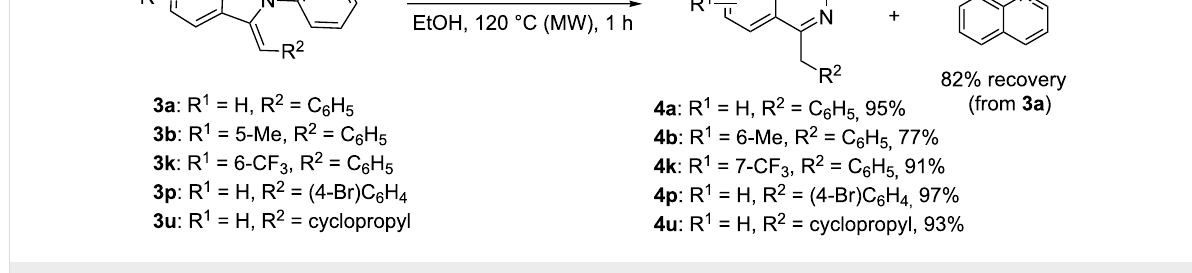
Scheme 4: Hydrazinolysis and removal of the directing group.